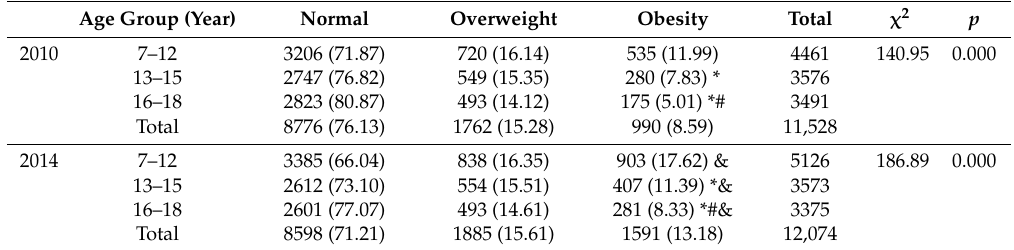
Table 2. The prevalence of obesity and overweight among age groups in 2010 and 2014 (%). Age Group (Year) Normal